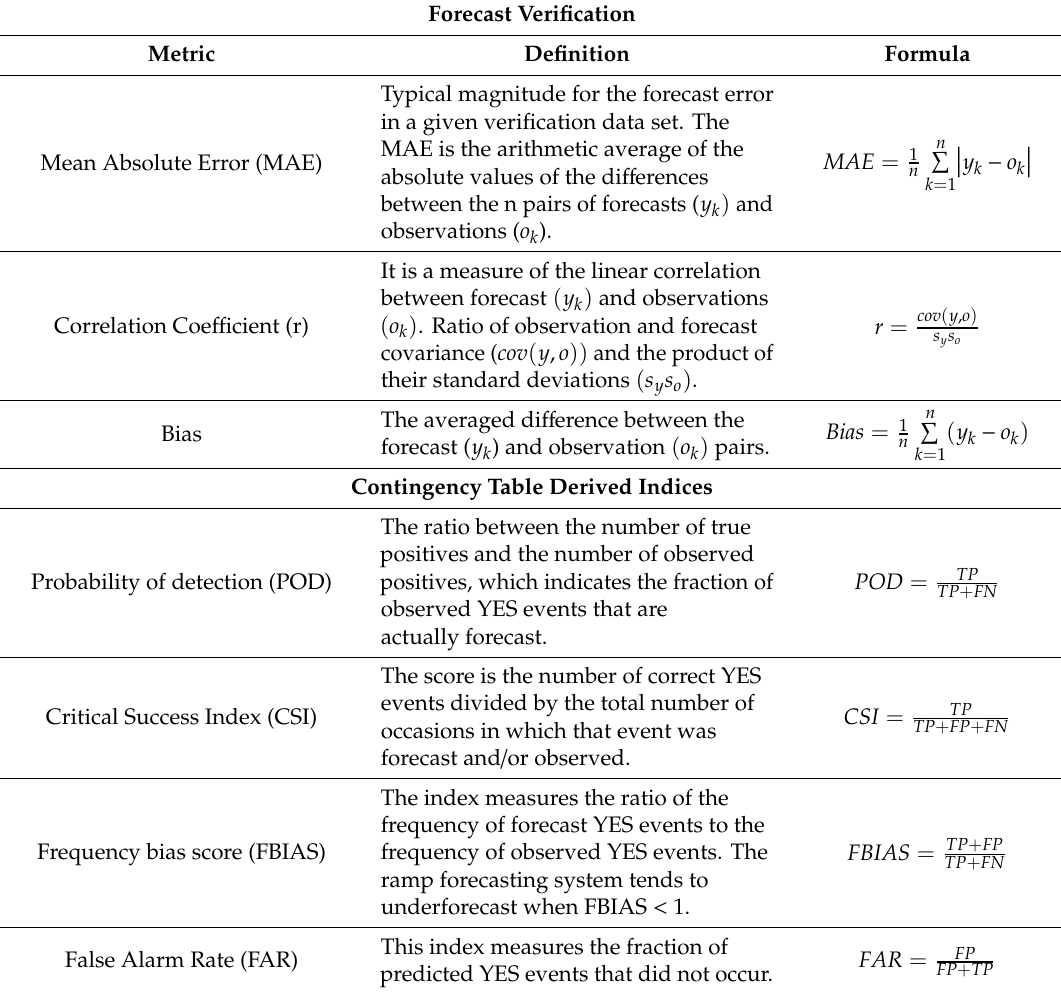
Table 2. Wind and ramp-event forecast